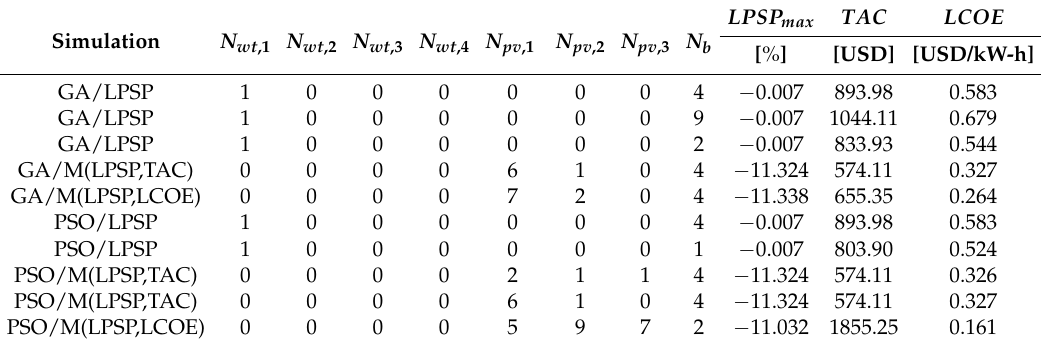
Table 7. Best results for Case I: Demand of non-interconnected zone.